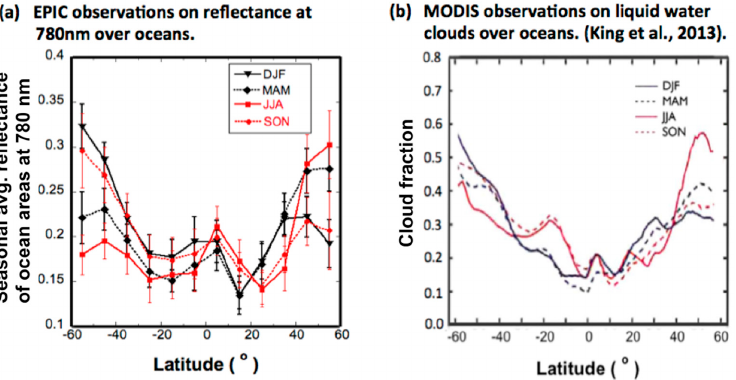
Figure 6. ( a ) The latitude distribution of EPIC’s seasonal average reflectance over oceans at 780 nm, and ( b ) the latitude distribution of MODIS’s water cloud fraction for four seasons. ( b ) Is from King et al. [18] with permission from IEEE Transactions on Geoscience and Remote Sensing.